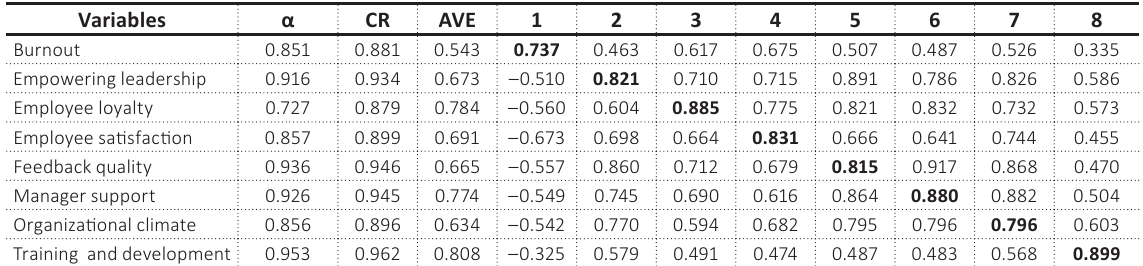
Table 1. Composite reliability, average variance extracted, correlations, and discriminant validity Variables